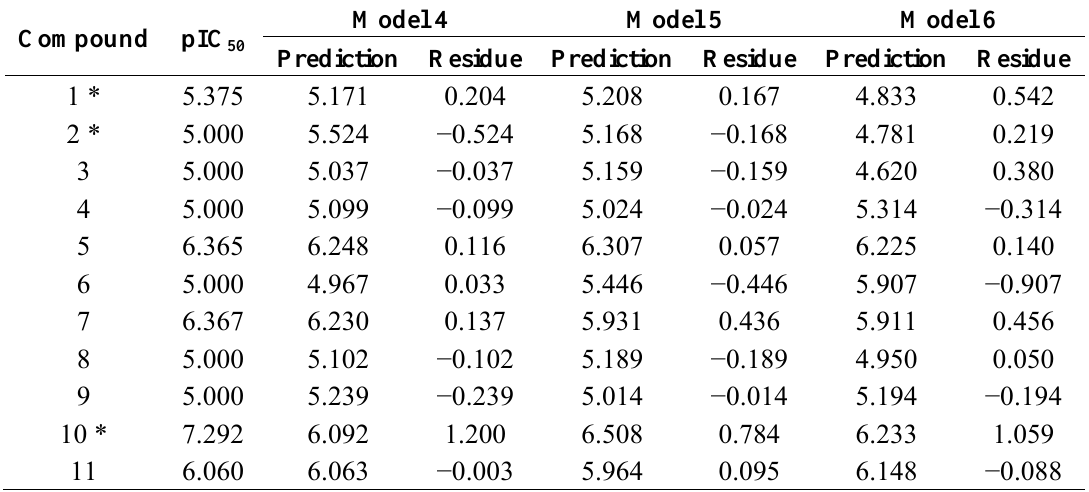
Table 4. The experimental pIC derived from the CoMSIA